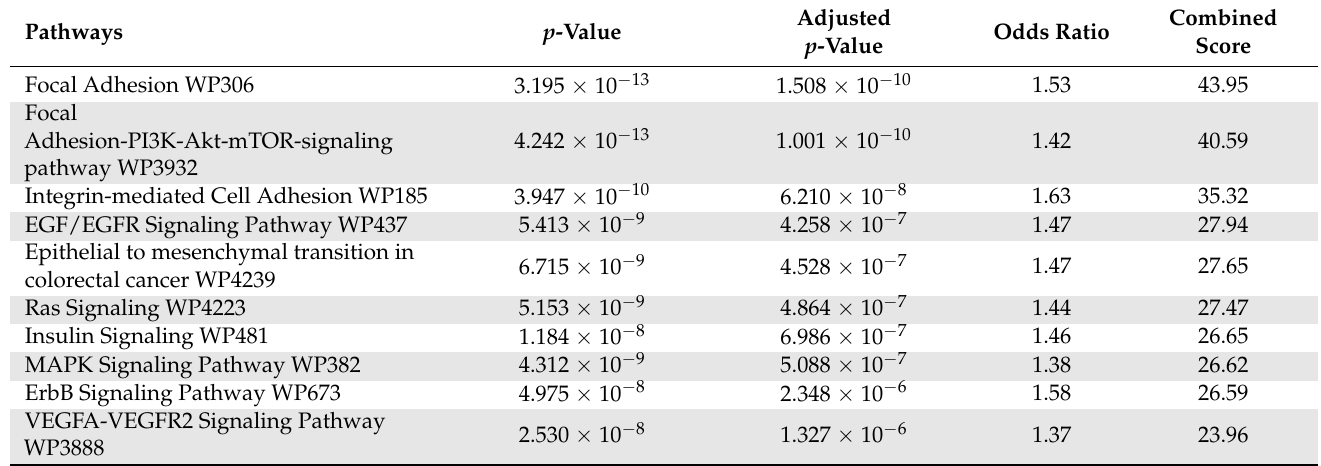
Table 1. Top enriched pathways in HUDEP2_L vs. HUDEP1_L DE miRNAs ranked by combined score